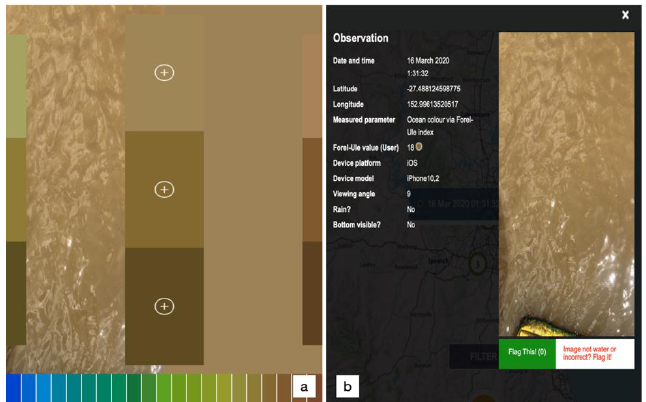
Figure 5. At the proper orientation, a photo is first taken and a color chart appears. The user is able to scroll through the color chart and select which color best matches the photo of the water ( a ). After uploading and processing on the EyeOnWater (EoW) server, the photo with all results is available on the webserver ( b ).